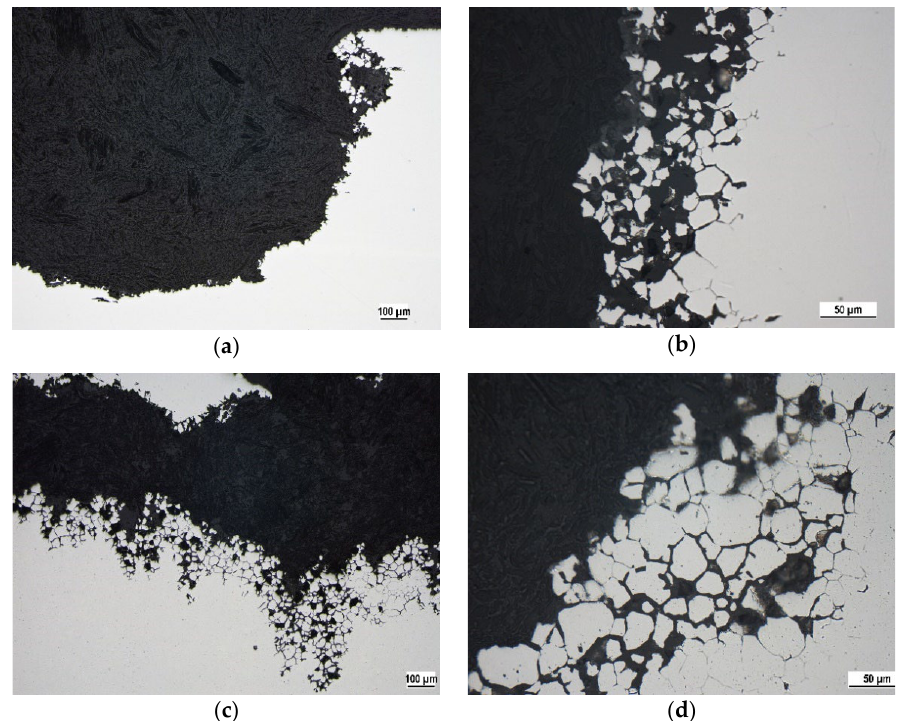
Figure 6. OM micrographs of the corrosion pits edges—S specimen after 24 h exposure in 1 M Cl − solution (represented by 5 wt % FeCl 3 solution), cross section: ( a ) 20 ± 3 ◦ C, magnification 100 × ; ( b ) 20 ± 3 ◦ C, magnification 400 × ; ( c ) 50 ◦ C, magnification 100 × ; ( d ) 50 ◦ C, magnification 400 × .